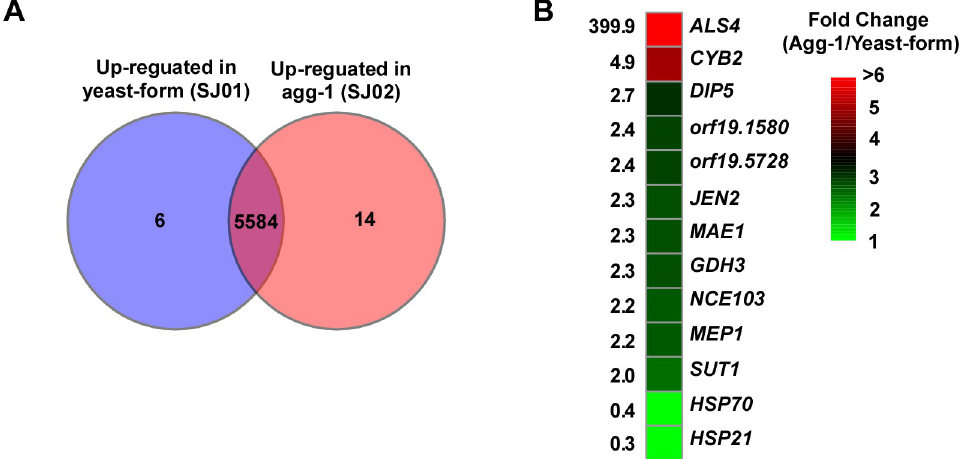
Fig 8. Global transcriptional profiles of the nonaggregative/yeast-form (SJ01) and aggregative-form (SJ02) strains of C . auris by RNA-Seq. (A) Venn diagram depicting differentially expressed genes. A twofold difference cut-off and false discovery rates (FDRs) less than 0.01 were used. (B) R package heatmap depicting the differentially expressed genes associated with biofilm development. Fold changes are shown.